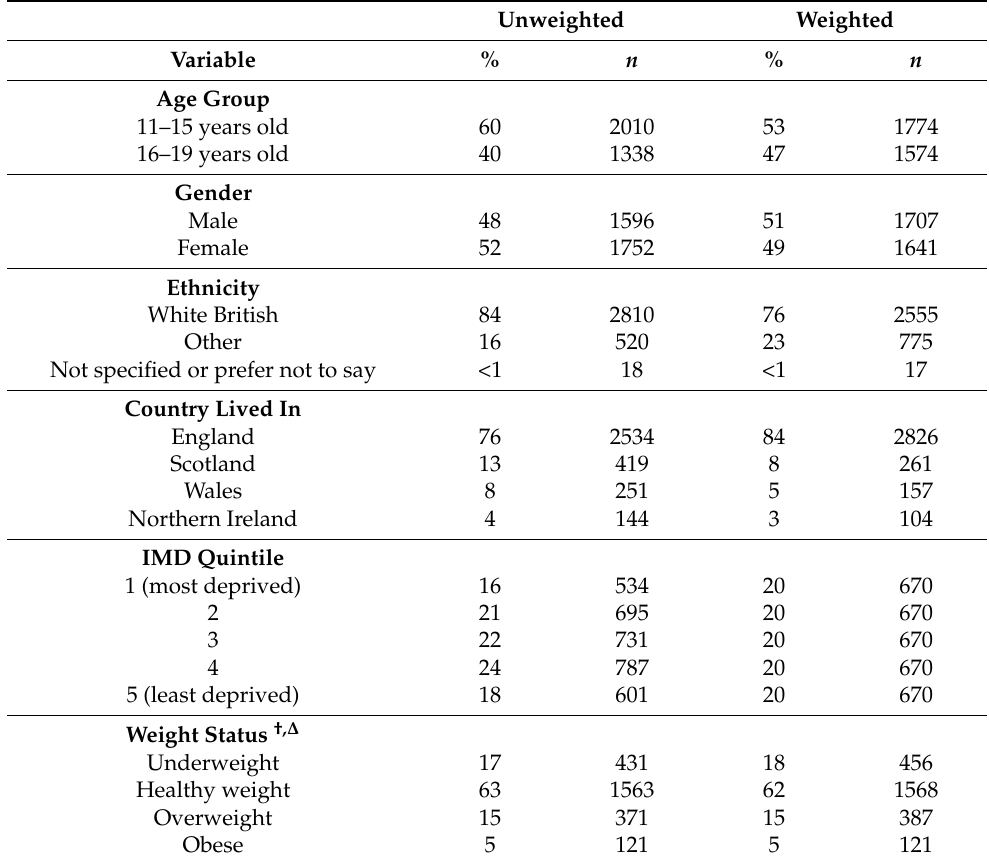
Base: All participants; † based on the extended International (IOTF) Body Mass Index Classification, including age and gender adjustments for 11–17 year olds; ∆ missing data due to missing height or weight